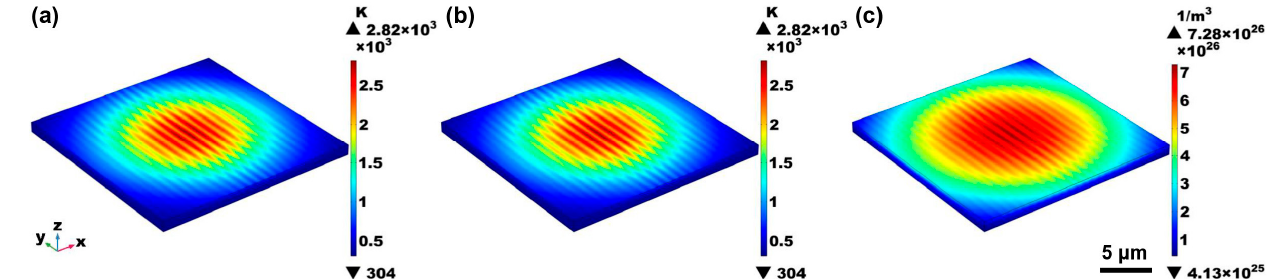
Figure 2. The evolution of the calculated ( a ) T e , ( b ) T l , and ( c ) N e at 6 ps.